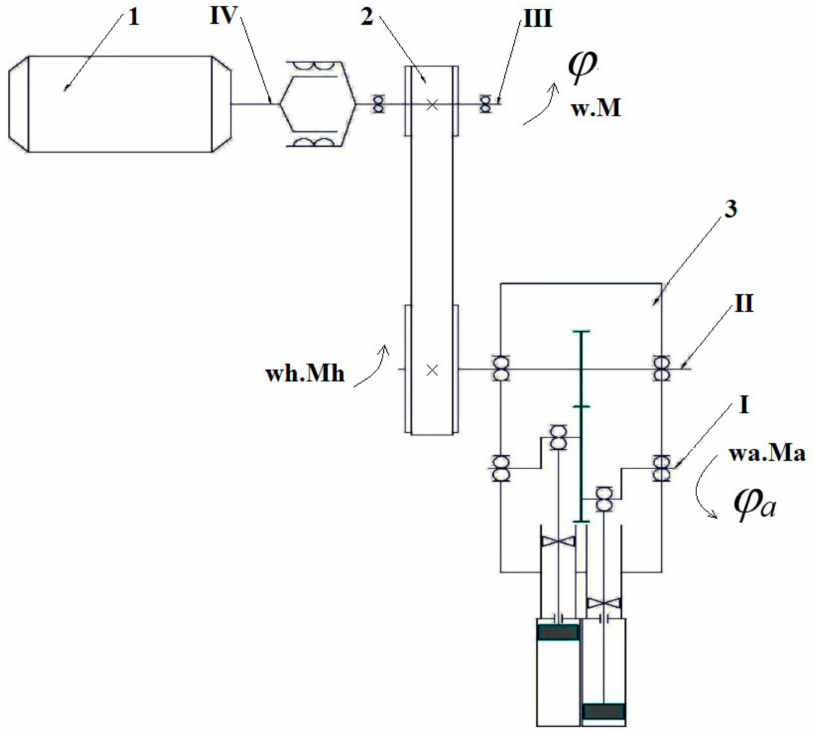
Figure 1. MPU Flow Chart: 1, pumping power; 2, power transmission; and 3,